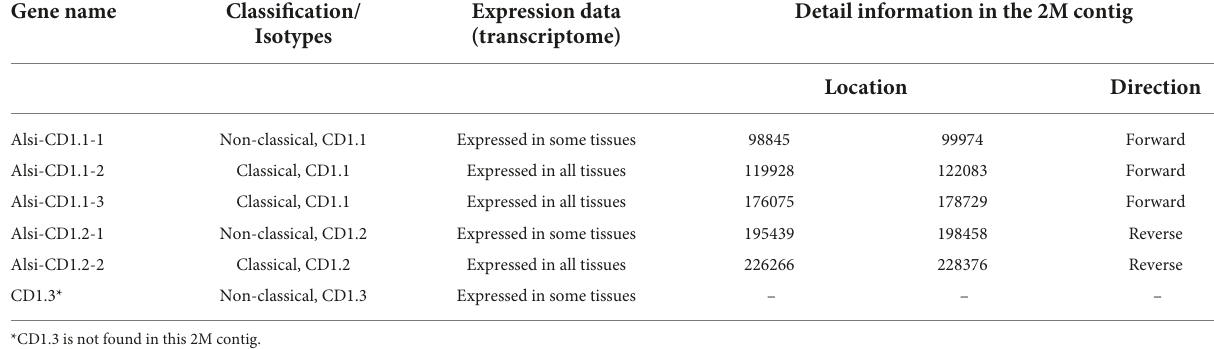
TABLE 4 The information about CD1 genes in Chinese alligator.